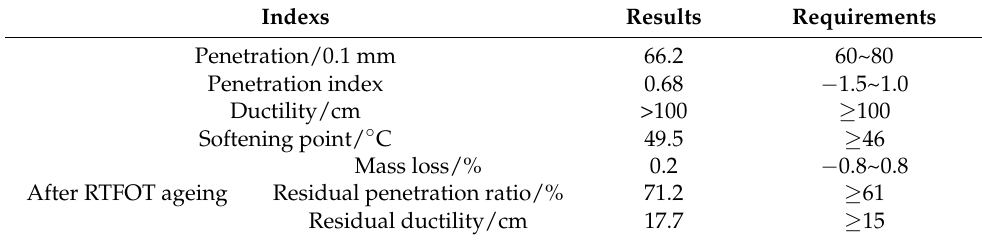
Table 1. Technical indexes of matrix asphalt.